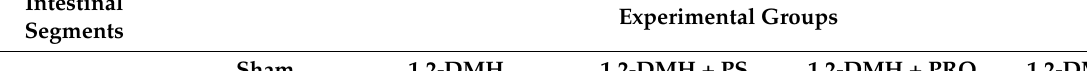
Table 1. Number of ACF per field in the three colonic segments. The values are expressed as the median, minimum, and maximum, where # p < 0.05 vs. Sham and * p < 0.05 vs. group 1,2-DMH. The data were analyzed using the Kruskal–Wallis test followed by the Dunn’s